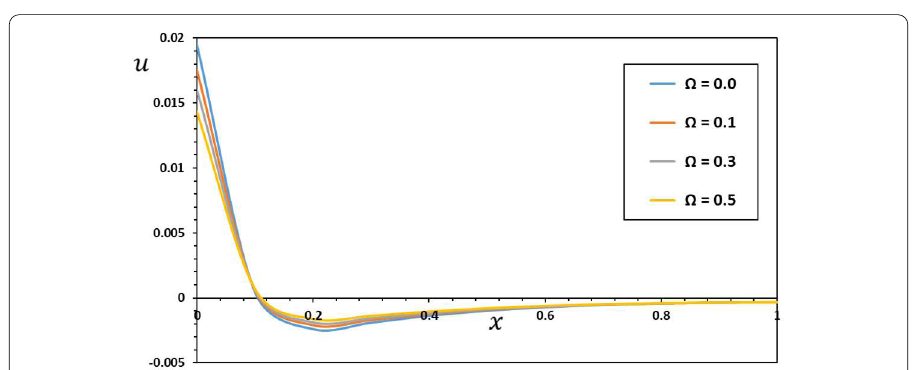
Figure 4 The effect of rotation ( (cid:5) ) on the variation of displacement u